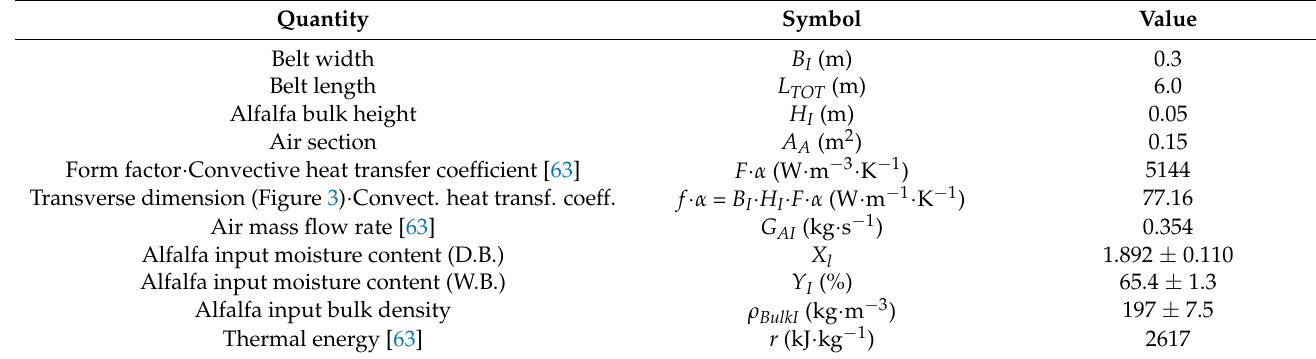
Figure 5. Pilot conveyor-belt dryer with tangential flow. Table 1. Geometrical and some operational data of the pilot dryer.